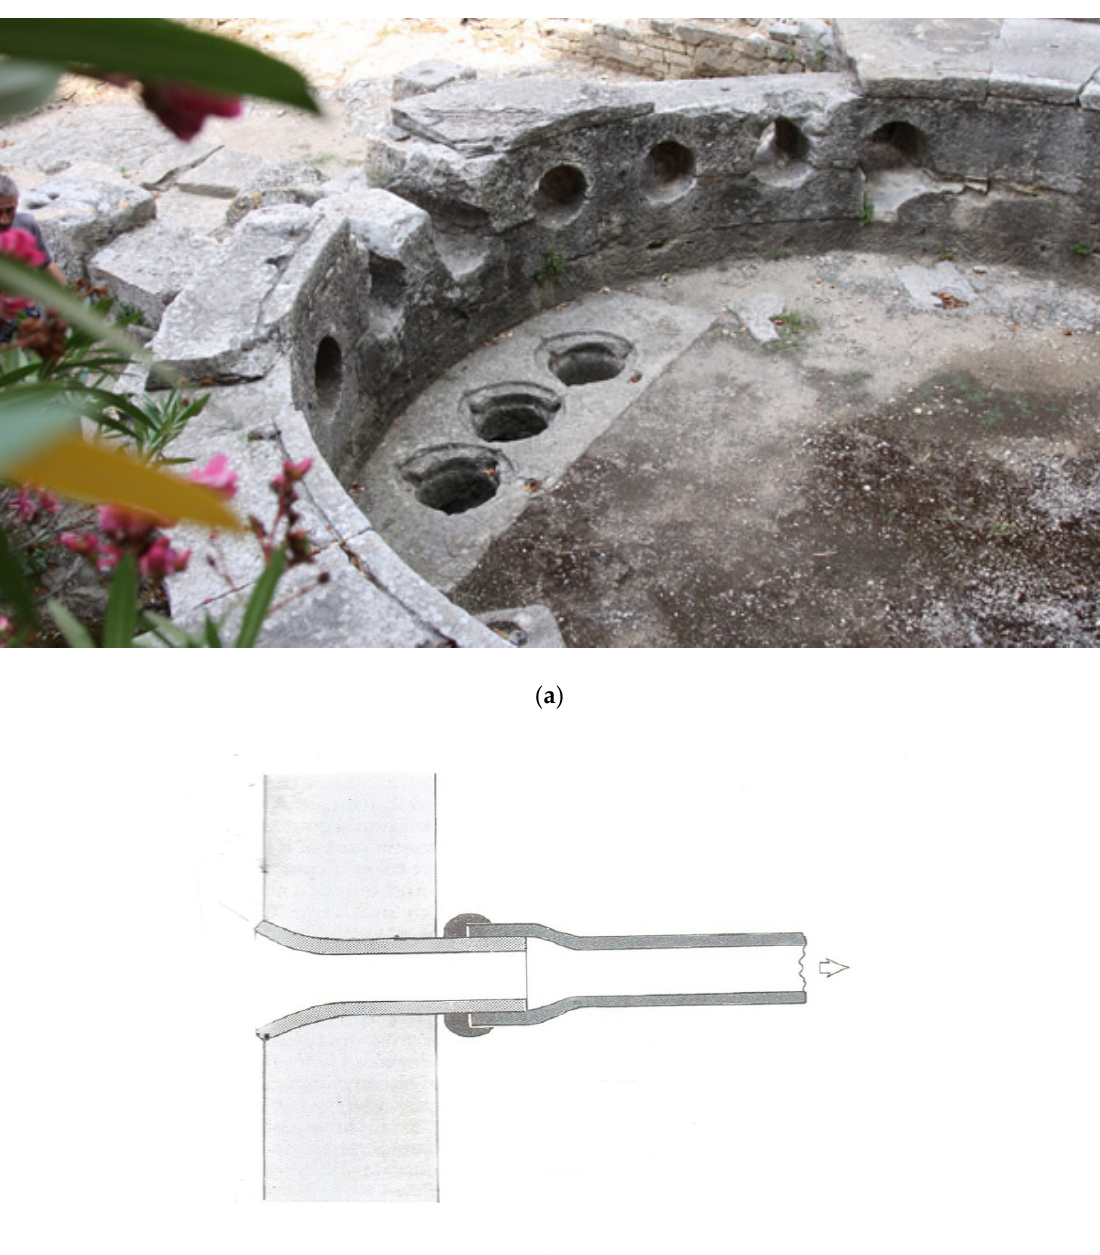
Figure 6. ( a ) Interior view of the Nîmes castellum showing three floor drainage ports. Port covers can be moved to adjust flow drainage flow rate output to match aqueduct input flow rate. ( b ) Typical calyx insert adjoining a pipeline marked with a flow rate value (in quinaria ) for attachment to a pipeline to limit its flow rate to a prescribed value.